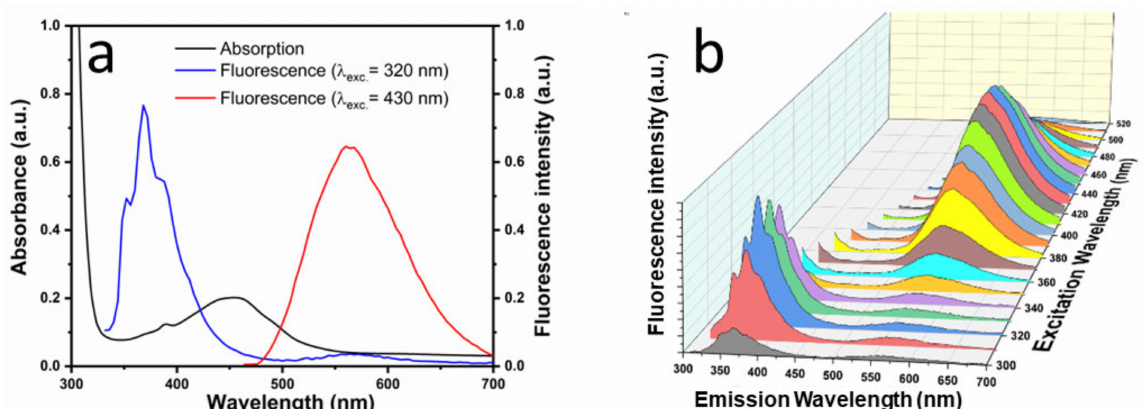
Figure 3. ( a ) UV-Vis absorption spectrum (black curve) and fluorescence spectra excited at λ exc = 320 nm (blue) and λ exc = 430 nm (red) of NSCDs; ( b ) emission spectra at different excitation wavelengths.